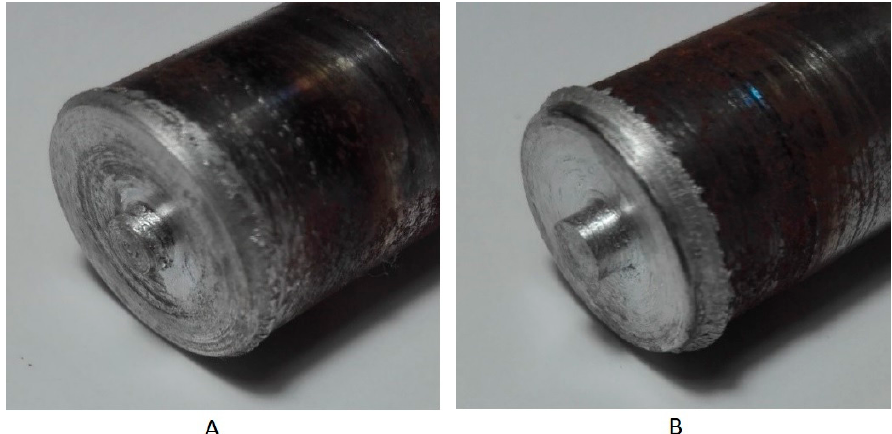
Figure 1. ( A ) Tool with flat 16 mm shoulder diameter and 3 mm diameter cylindrical pin of 1.8 mm height. ( B ) Tool with flat 16 mm shoulder diameter and 4 mm diameter cylindrical pin of 1.8 mm height.